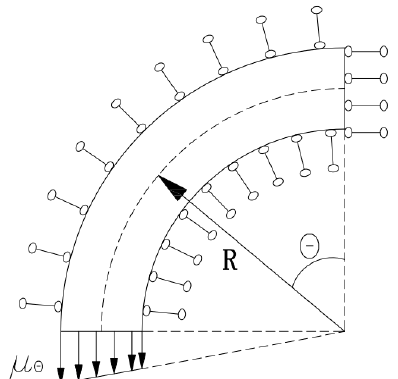
Figure 6. Diagram of the ideally assumed hose segment.